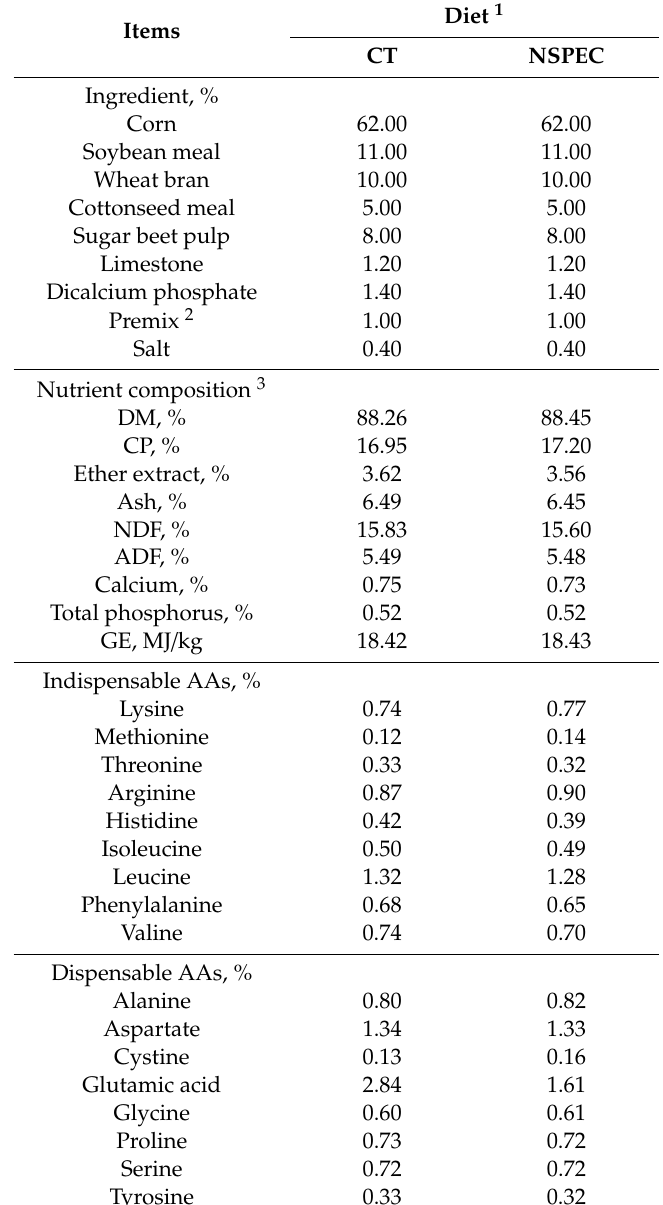
Table 1. The ingredient and nutrient composition of experimental diets (as-fed